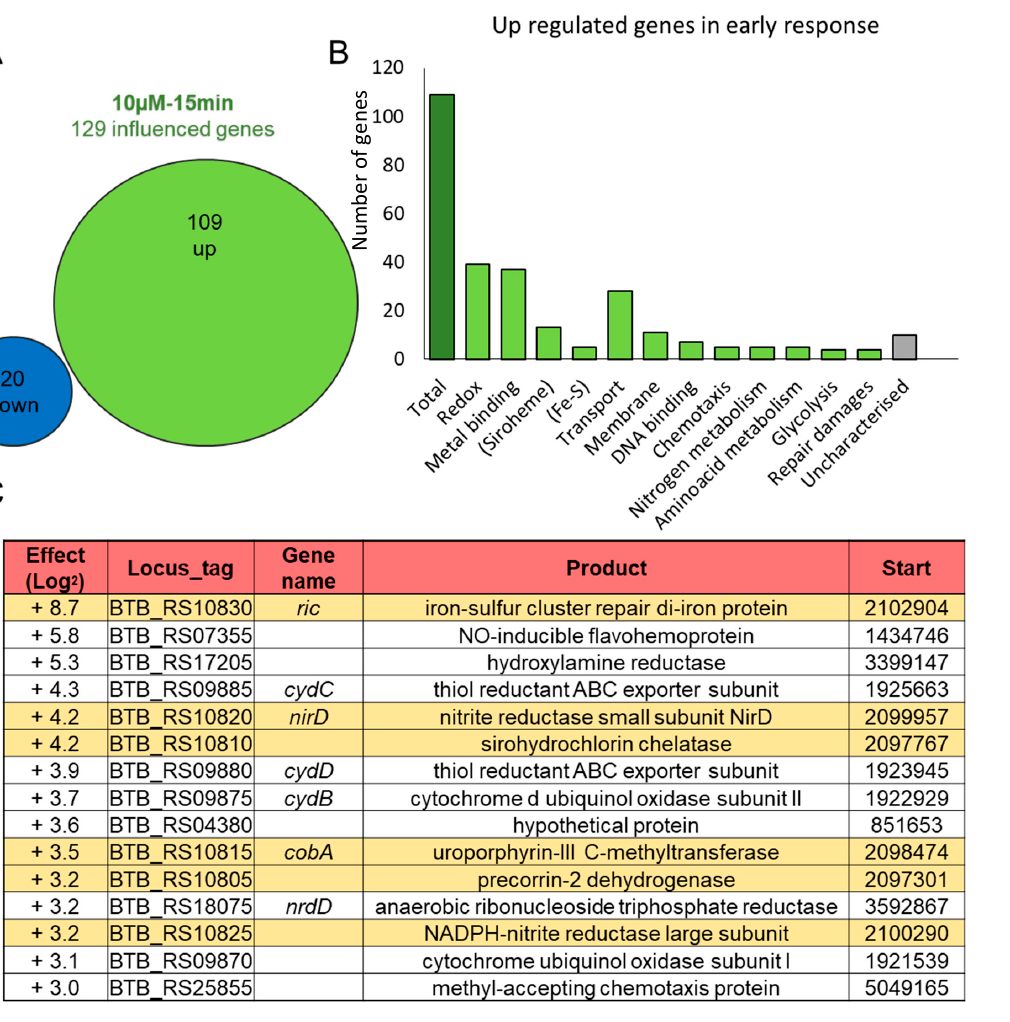
Figure 2. Characterization of the early response to NO stress by analysis of gene expression after 15 min and 10 µM of NO; ( A ) Venn diagram of the 129 genes found as impacted by the addition of 10 µM of NO; ( B ) Distribution of the 109 up-regulated genes in functional groups; ( C ) Listing of the 15 most impacted genes, all are up-regulated. The first column is the log2 fold change of the expression level. The six genes highlighted in yellow are in the same chromosomal region.